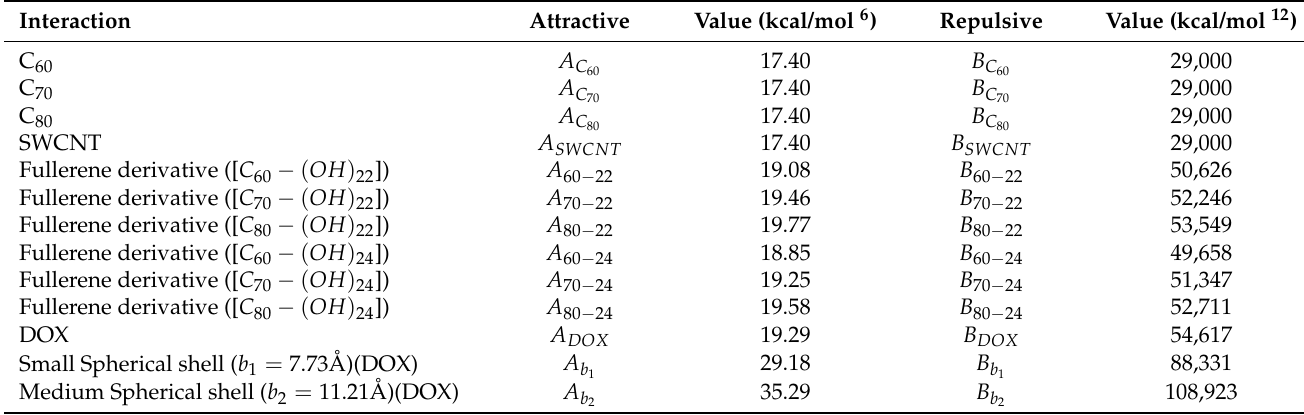
Table 2. Physical parameters ( A and B ) involved in this